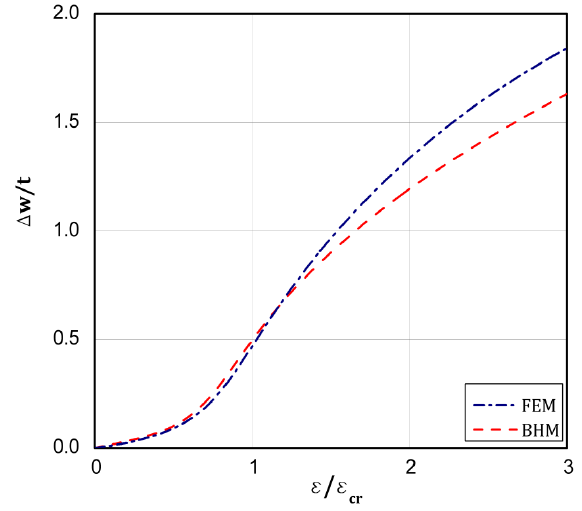
Figure 11. Dependence of ∆ w / t vs. ε / ε cr for variant B and type 4 of loads.